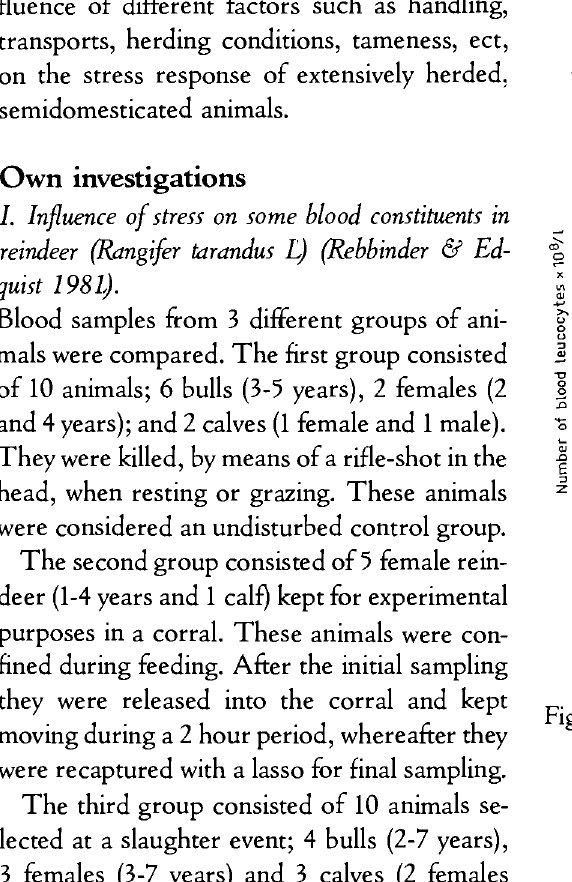
Fig. 4. Mean values of number of blood leucocytes in unstressed and stressed reindeer. I = Unstressed animals: Group I Ha = Experimental animals: Group Ha. Captured by hand and sampled animals, lib = Experimental animals: Group lib. Animals recaptured by means of lasso and sampled after being persued, kept moving, during 2 hours. Ill = Reindeer exposed to management stress. Group III. Samples obtained at slaughter